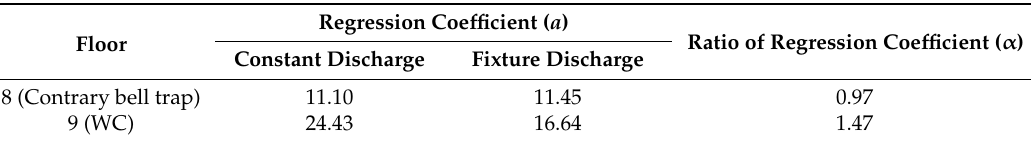
Figure 8. Scatter diagrams of the SDs of the pressure vibration in pipes and seal water fluctuation, as well as their primary regression equations. Table 4. Regression coefficient a and the ratio of regression coefficient of the constant discharge to the fixture discharge.